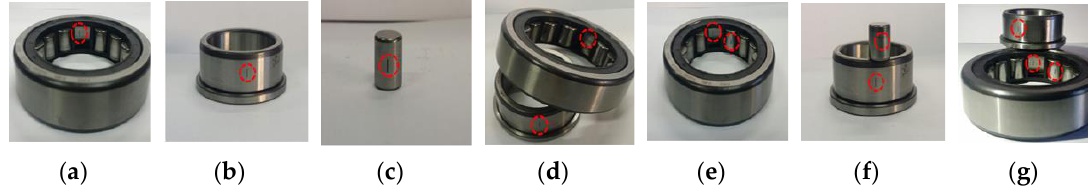
Figure 2. ( a ) Experimental setup to record fault data and ( b ) PCI-2 AE (Peripheral Component